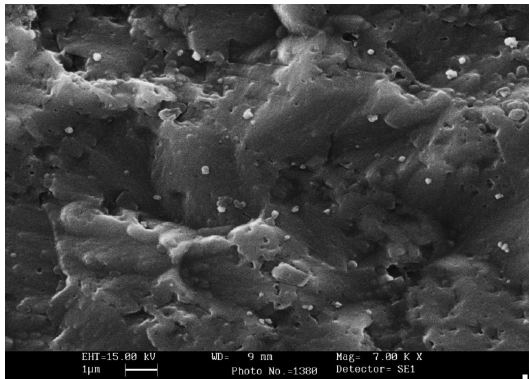
Figure 7. SEM image of the Stir zone for the Al